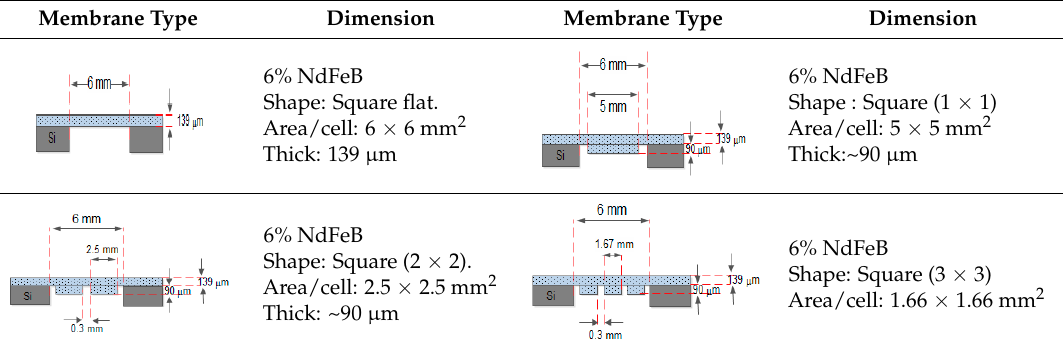
Table 1. The dimension of the designed polymer composite membrane.